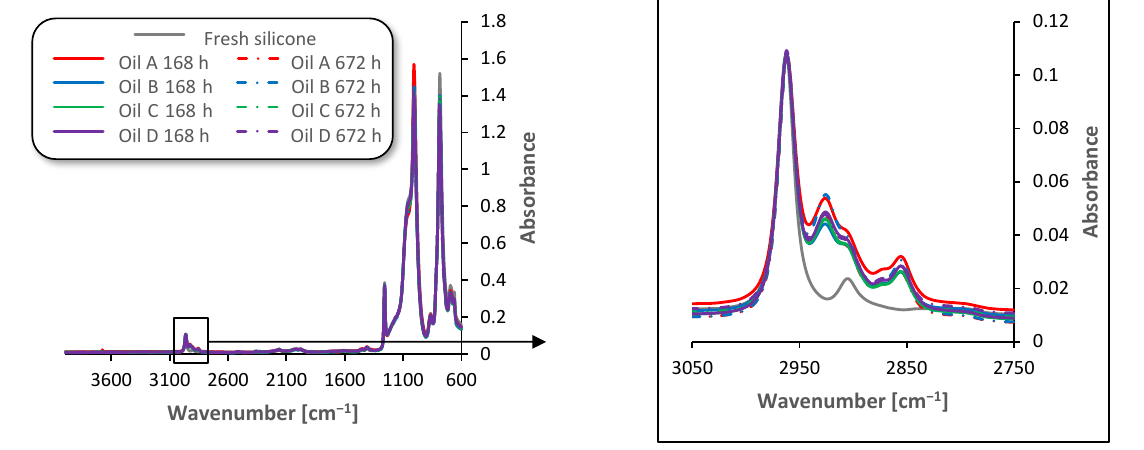
Figure 10. ATR-FTIR absorbance spectra (Beer’s Law) of the silicone samples.